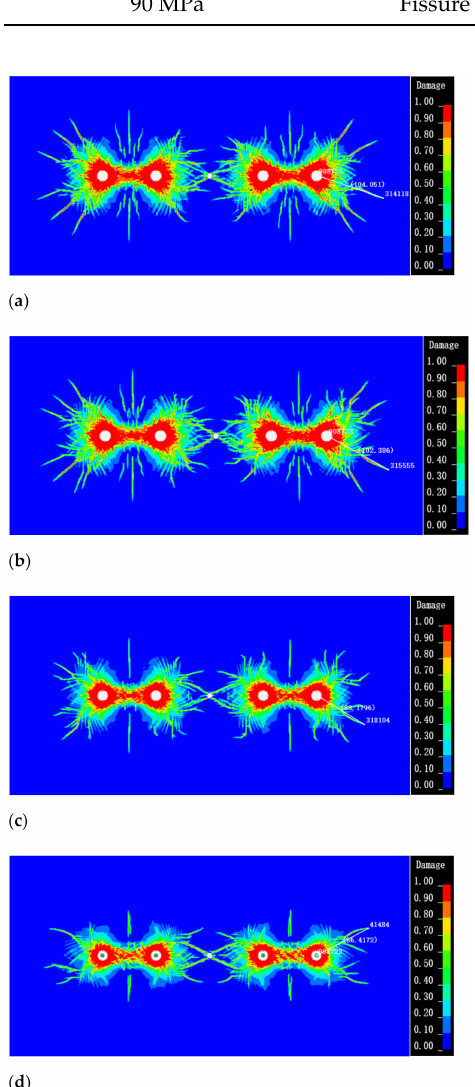
Figure 9. Evolution and distribution characteristics of cracks between blasting roof cutting holes under different confining pressures. ( a ) Model applied pressure 20 MPa. ( b ) Model applied